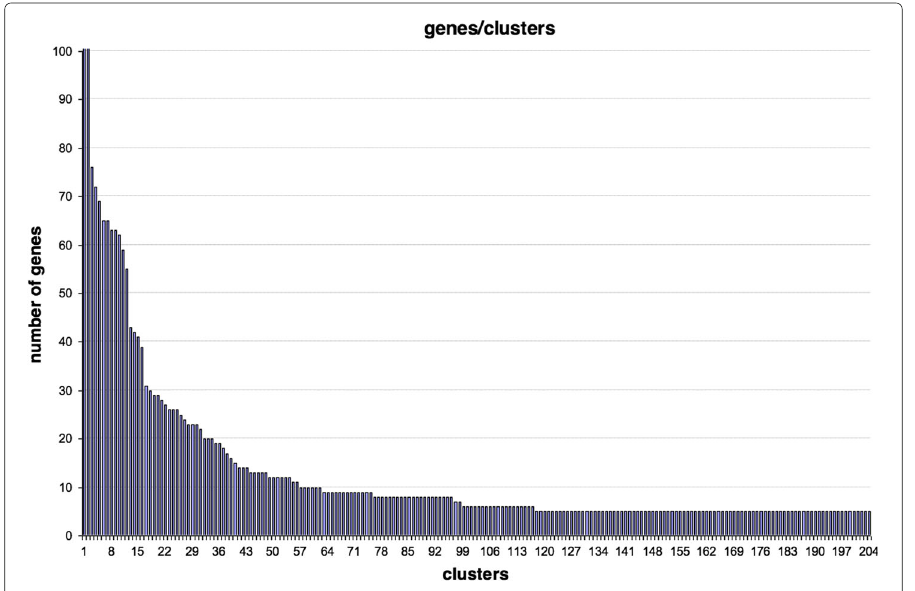
Fig. 7 Number of genes per cluster